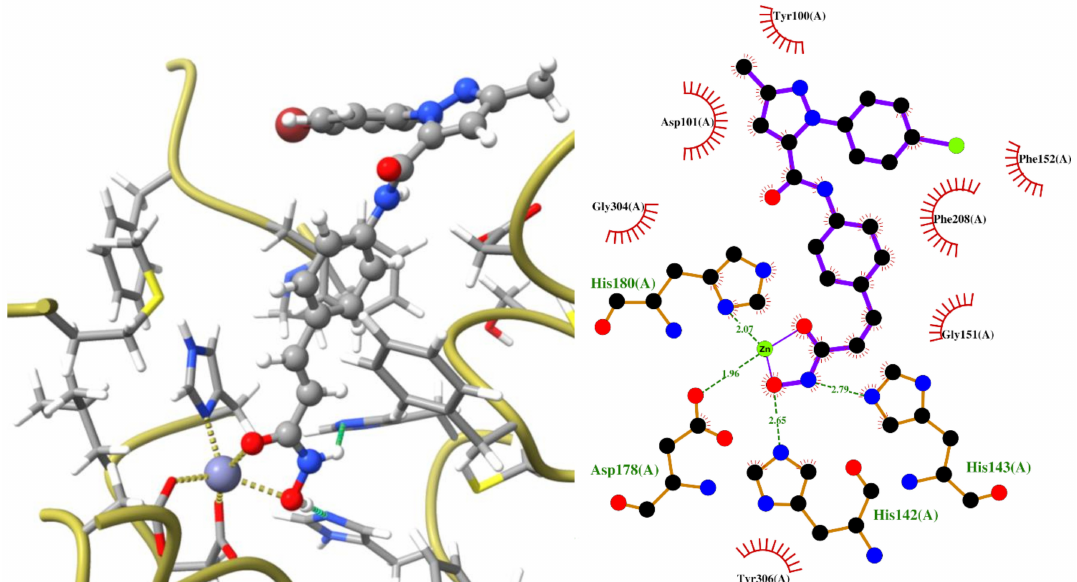
Figure 6. 3D and 2D view of the interactions for 3 inside the binding pocket of HDAC8 (PDB ID: 1T64); lengths in Å. The 3D plot was generated by UCSF ChimeraX (release 0.8, Resource for Biocomputing, Visualization, and Informatics, San Francisco, CA, USA) [26]; hydrogen bonds are shown as green dotted lines, while coordination bonds are in yellow. The 2D plot was generated by LigPlot + (2.1, EMBL-EBI, Wellcome Genome Campus, Hinxton, Cambridgeshire, United Kingdom) [27]; hydrogen bonds are shown as green dotted lines, while the spoked arcs represent residues making nonbonded contacts with the